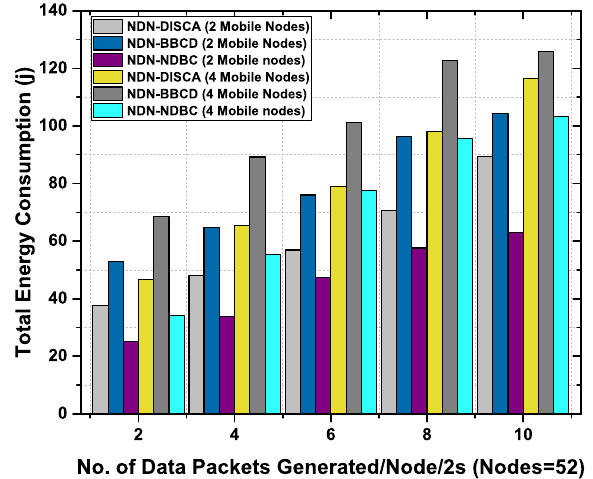
Figure 10. Total energy consumption as a function of number of data packets generated per 2 s with 48 static nodes and (2–4) mobile